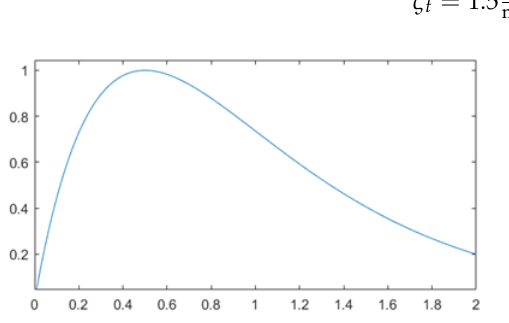
Figure 3. The plot of Equation (35).